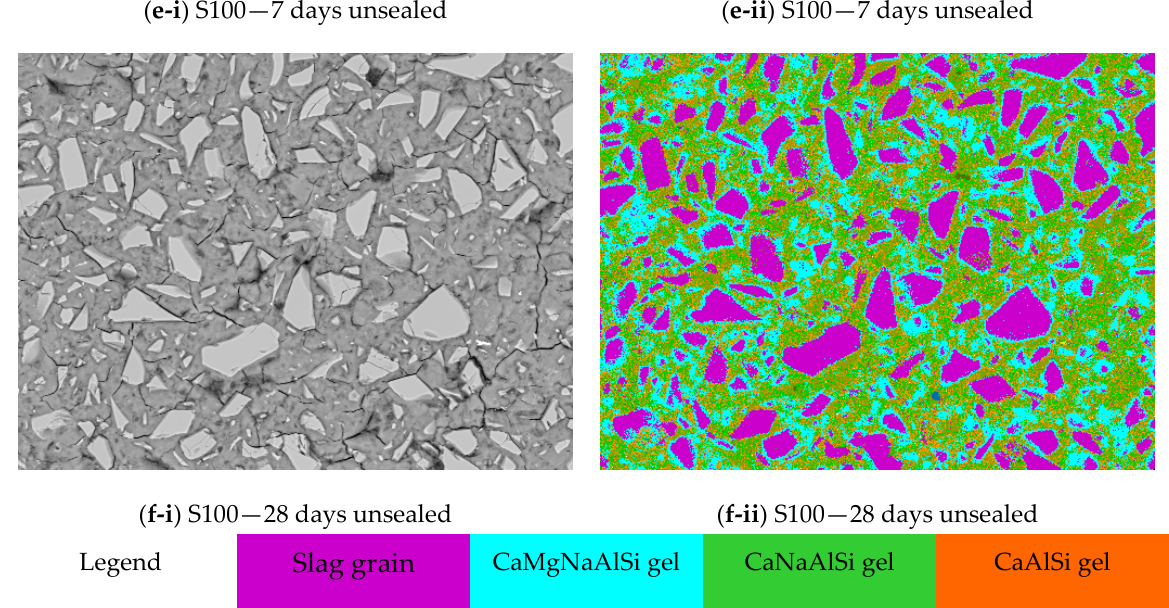
Figure 15. SEM-BSE images ( a–f-i ) of of paste S100’s microstructure at different curing periods, with mapped compound domains of the different phases ( a–f-ii ). Image width = 250 μm.